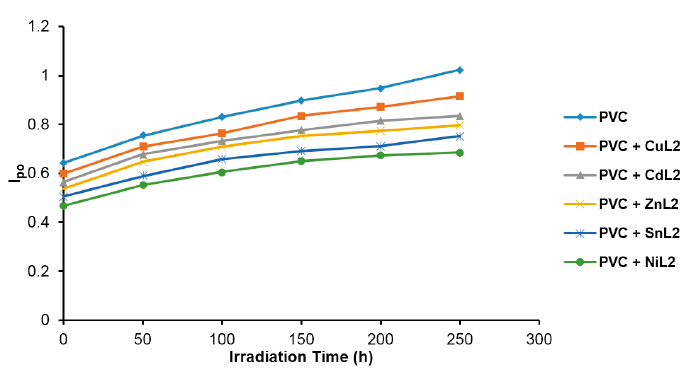
Figure 5. Effect of irradiation time (250 h) on I PO and for PVC films (40 μ m thickness) containing ML 2 (0.5 wt %).